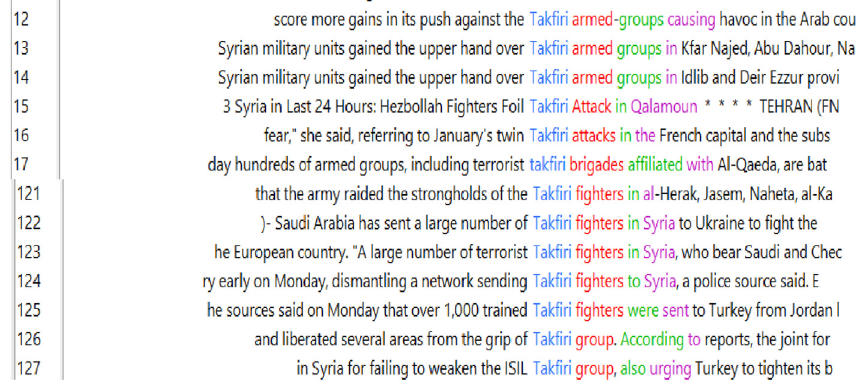
Figure 9: Concordance lines of Tak fi ri